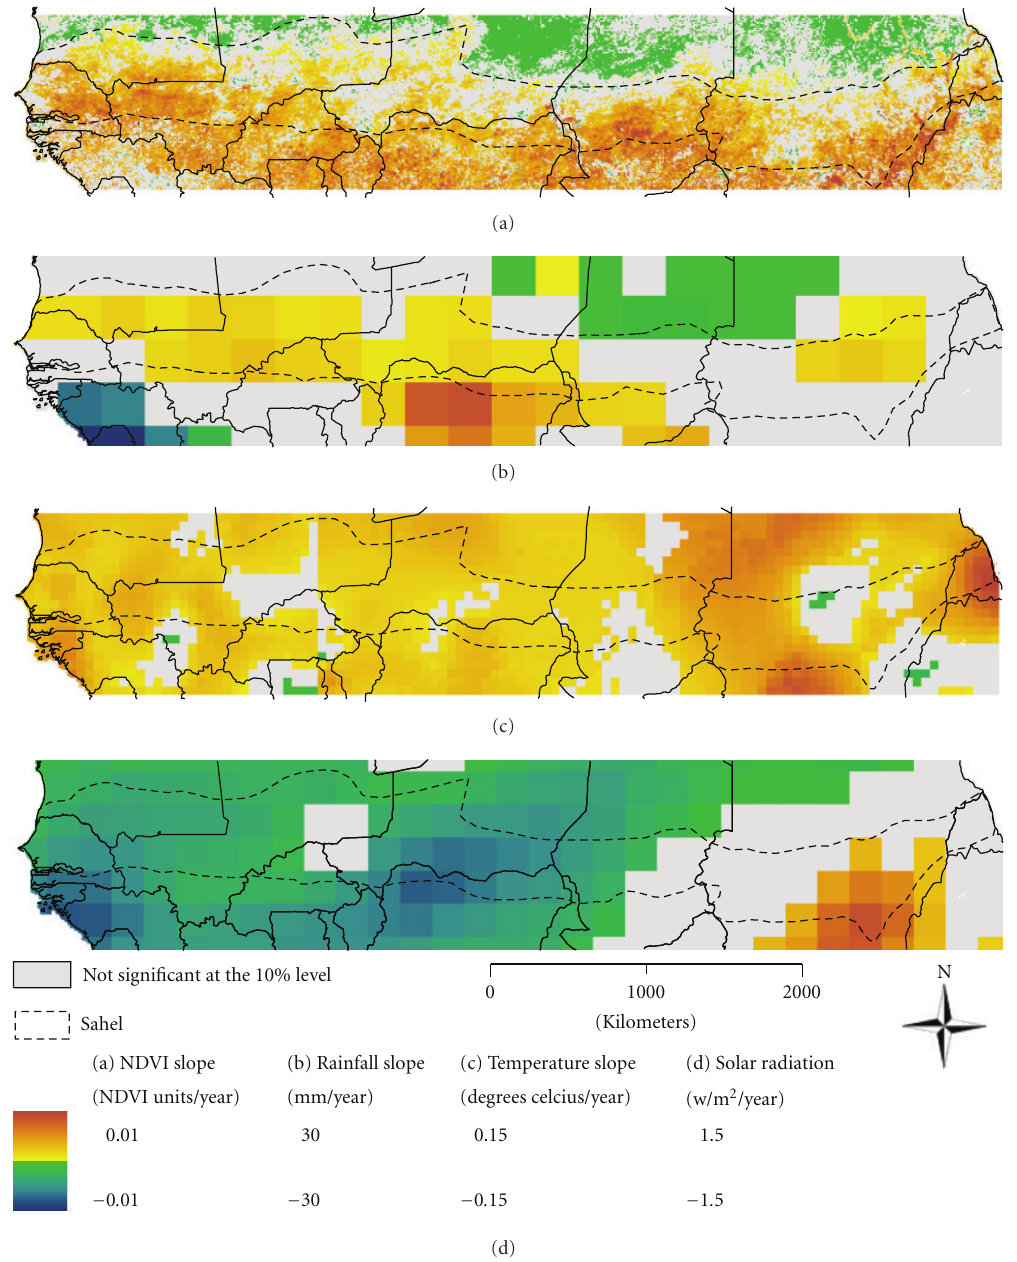
Figure 3: Per-pixel linear trend analysis Sahel 1982–2007 of (a) GIMMS NDVI anomalies, (b) CMAP rainfall anomalies, (c) NCEP GHCN/CAMS gridded air temperature, and (d) NCEP-DOE gridded surface downward solar radiation flux anomalies. Anomalies are with respect to the 1982–2007